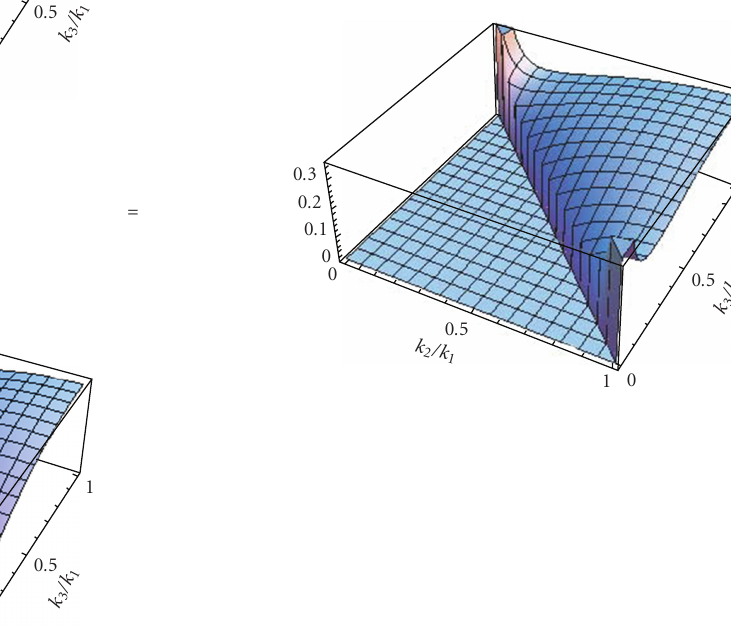
higher-orders of ζ from, for example, (cid:13) ζ 3 scale-invariant example, the extra terms are still highly